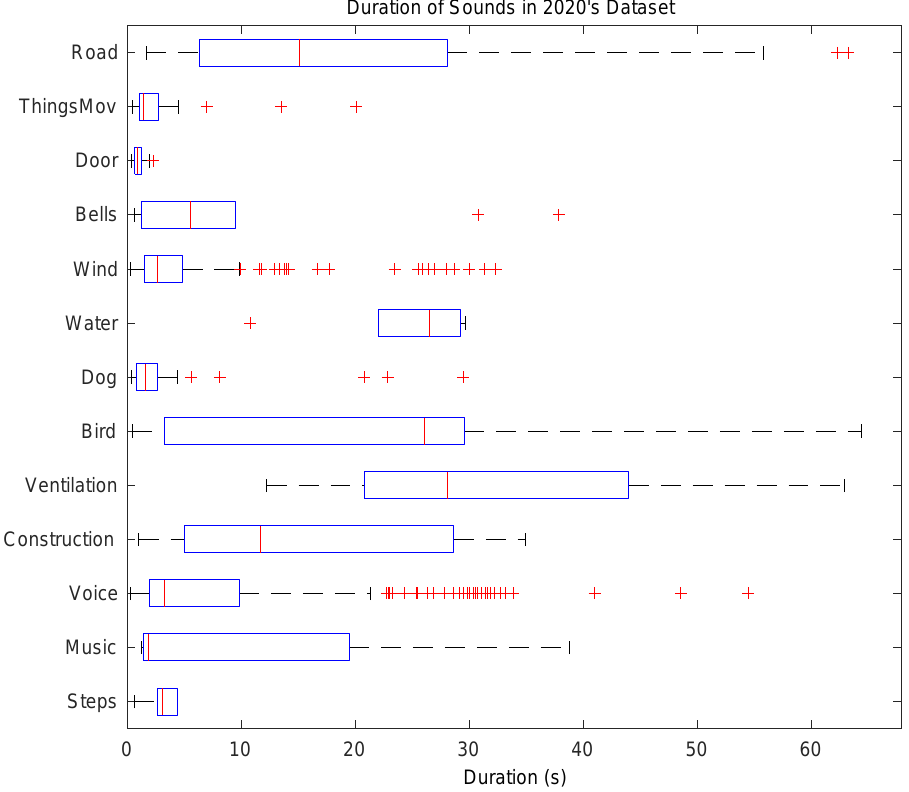
Figure 4. Boxplot of the duration of the different sound elements in the 2020 Sons al Balcó campaign. Red crosses indicate the